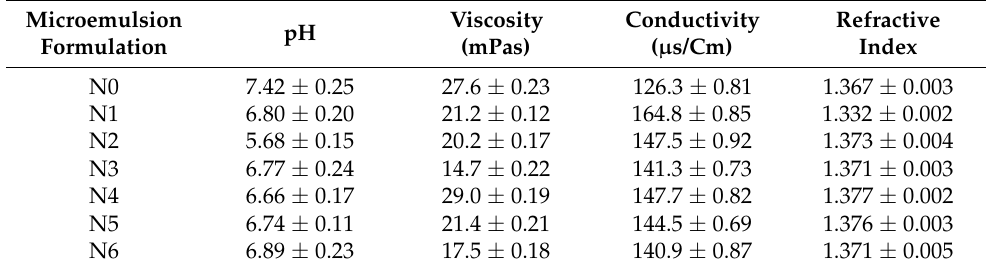
Table 4. Physiochemical parameters of the prepared microemulsions.